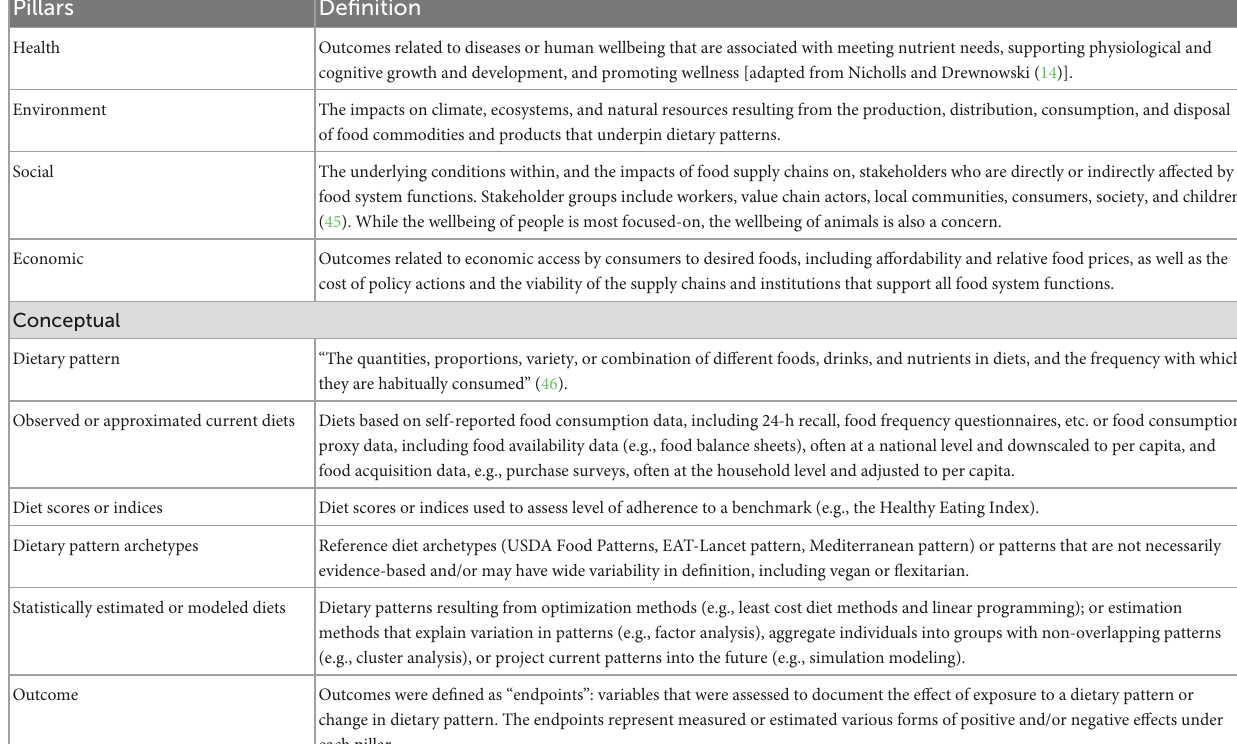
TABLE 1 Definitions and conceptual scope of terms used. Pillars Definition Health